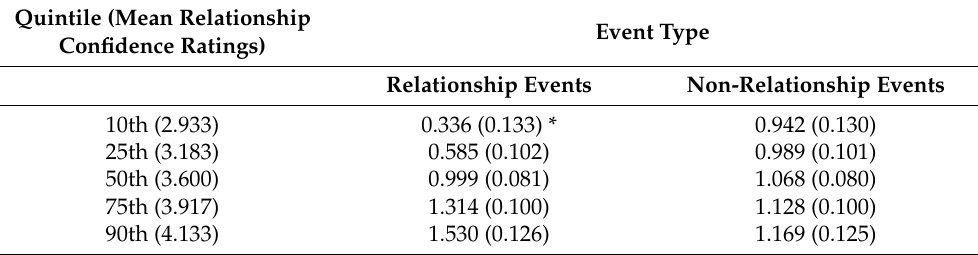
Table 4. Fading Affect Bias Regression Coefficients (SE) for Relationship Events and Non-Relationship Events across Quintiles (Mean Rating) of Relationship Confidence Ratings (large positive coefficients represent large FAB).